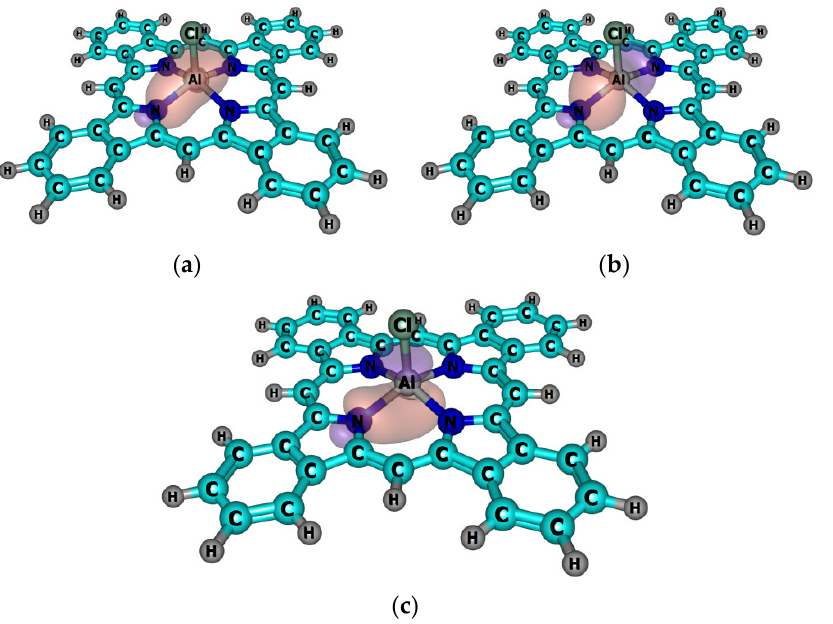
Figure 3. Schemes of the dominant donor–acceptor interactions between the Al and TBP ligand. ( a ) The result of the orbital interaction of the type LP(N) → 3s(Al) (E(2) = 40.7 kcal mol −1 ); ( b ) the result of the orbital interaction of the type LP(N) → 3p y (Al) (E(2) = 60.0 kcal mol −1 ); ( c ) the result of the orbital interaction of the type LP(N) → 3p z (Al) (E(2) = 12.2 kcal mol −1 ). Only one of the four corresponding interactions is demonstrated.